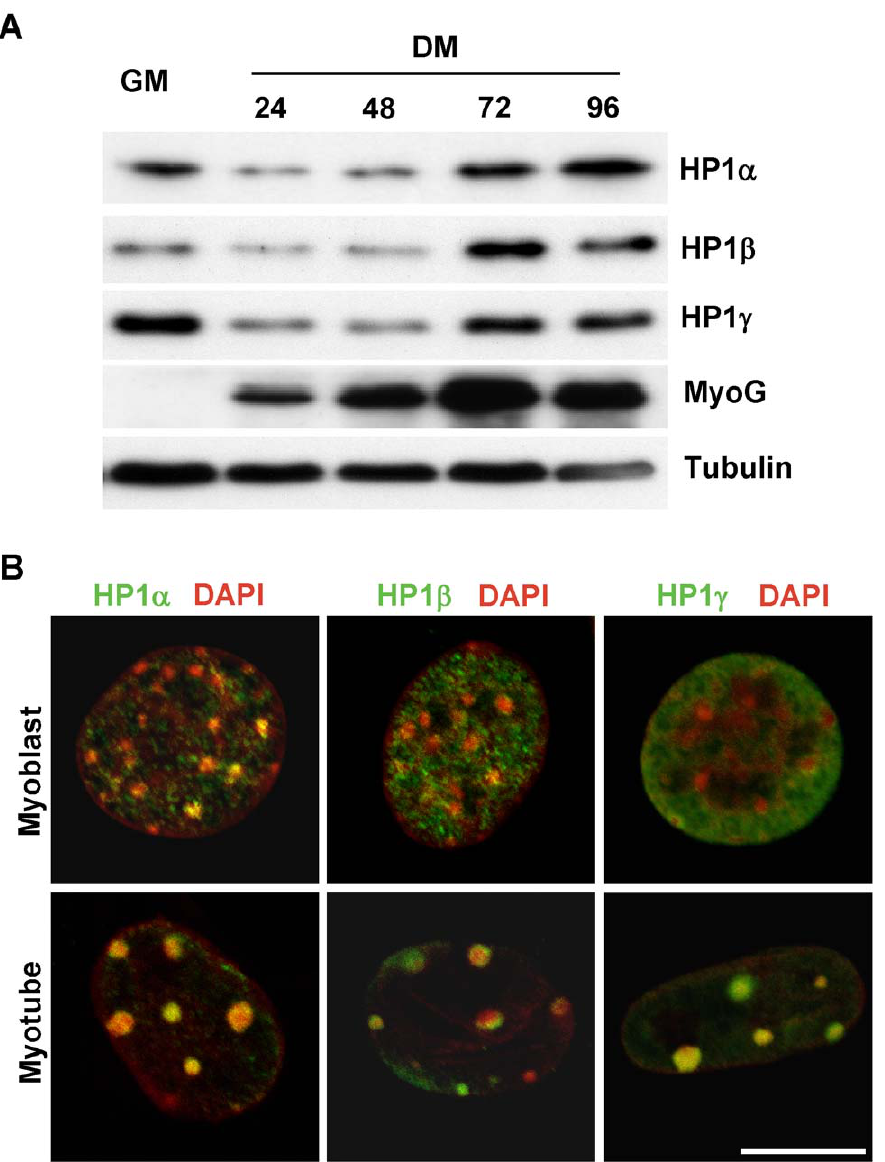
Figure 1. Expression and nuclear distribution of HP1 proteins during skeletal muscle differentiation. A. C2C12 cells were cultured in GM (growth medium) or DM (differentiation medium) and collected at indicated time points. Total protein was extracted and subjected to Western blotting. B . Confocal fluorescence microscopy was performed on C2C12 myoblasts and myotubes after immunostaining for the indicated HP1 protein (green) and DAPI (converted to red). Scale bar equals 10 m m.